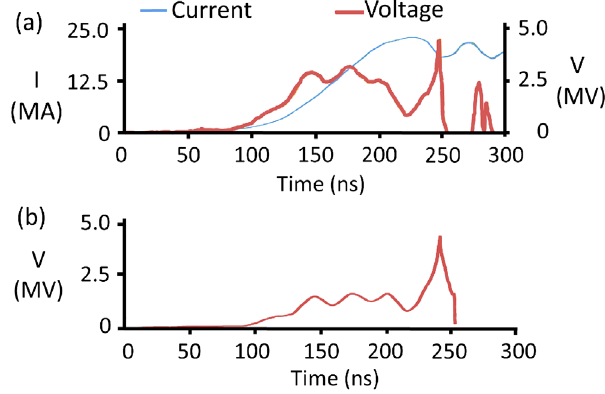
FIG. 5. (a) The current and voltage at the CSMITL electron injector and (b) the voltage at r ¼ 8 cm are shown for the 0 . 6 Ω CSMITL. The voltage at r ¼ 8 cm, the transition Z o min ¼ between the CSMITL and the disk feed, is the same within 1% with and without gap closure. and compute the electron current as the difference between the anode current and the cathode current. The difference between the electron current in one element and the electron current in the previous element is the sum of the retrapped current and the electron loss current in that element. The difference between the total current between the injector and the load (a distance that is modeled by many elements) is assumed to be electron loss currents and is shown in Fig. 6, with and without gap closure. With and without gap closure, the peak current occurs at 220 ns in Fig. 6(a) with the CSMITL and the electron loss